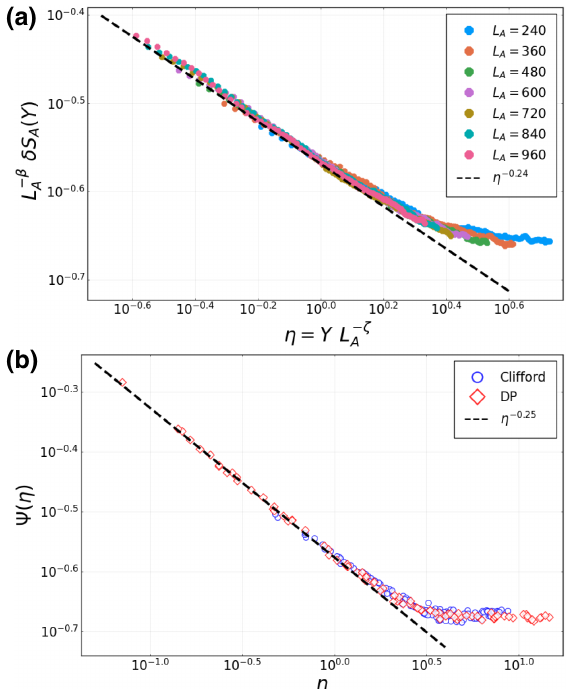
FIG. 4. (a) The mean subleading entanglement entropy ( Y ) (cid:7) [see Eq. (12)] in the Clifford circuit for various val- (cid:6) S sub A ues of L A and Y , collapsed against the scaling function (cid:10)(η) [defined in Eq. (19)]. (b) The scaling function (cid:10)(η) extracted ( Y ) in a numerical simulation of directed polymers, from F sub A rescaled and plotted on top of the same scaling function extracted from (a). In both panels, the insets are the same data, but plot- ted on a log-log scale. The directed polymers have length L A ≤ 32768 and live at zero temperature [see Eq. (10)]. For the Clif- ford circuit data we take the best fits to the exponents, β = 0.34, ζ = 0.63; whereas for the directed polymers we find the best fits are β = 0.37, ζ = 0.66.